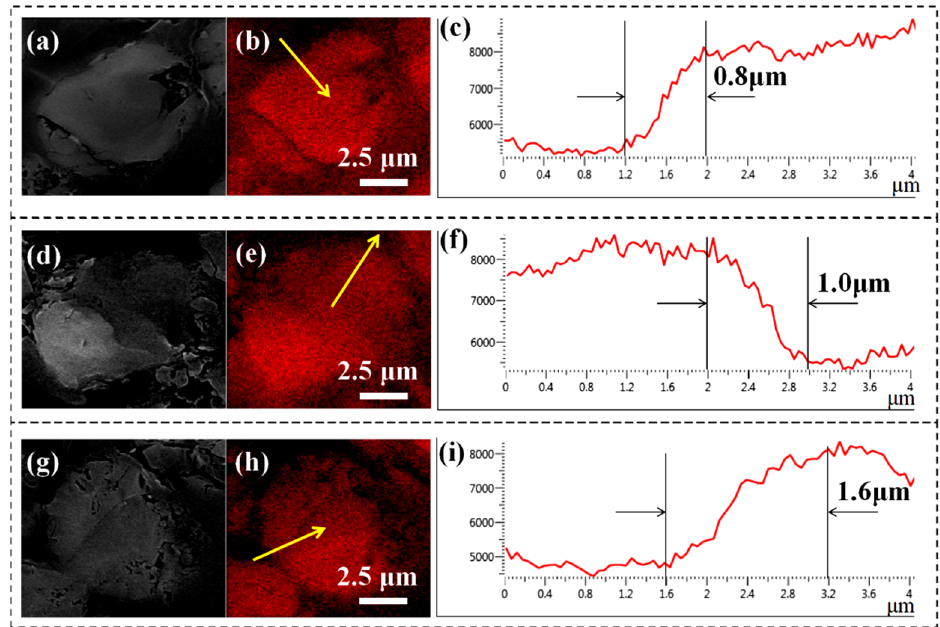
Figure 9. ( a ) Storage modulus (E ′ ) and ( b ) tan δ of different CF/EP composites.